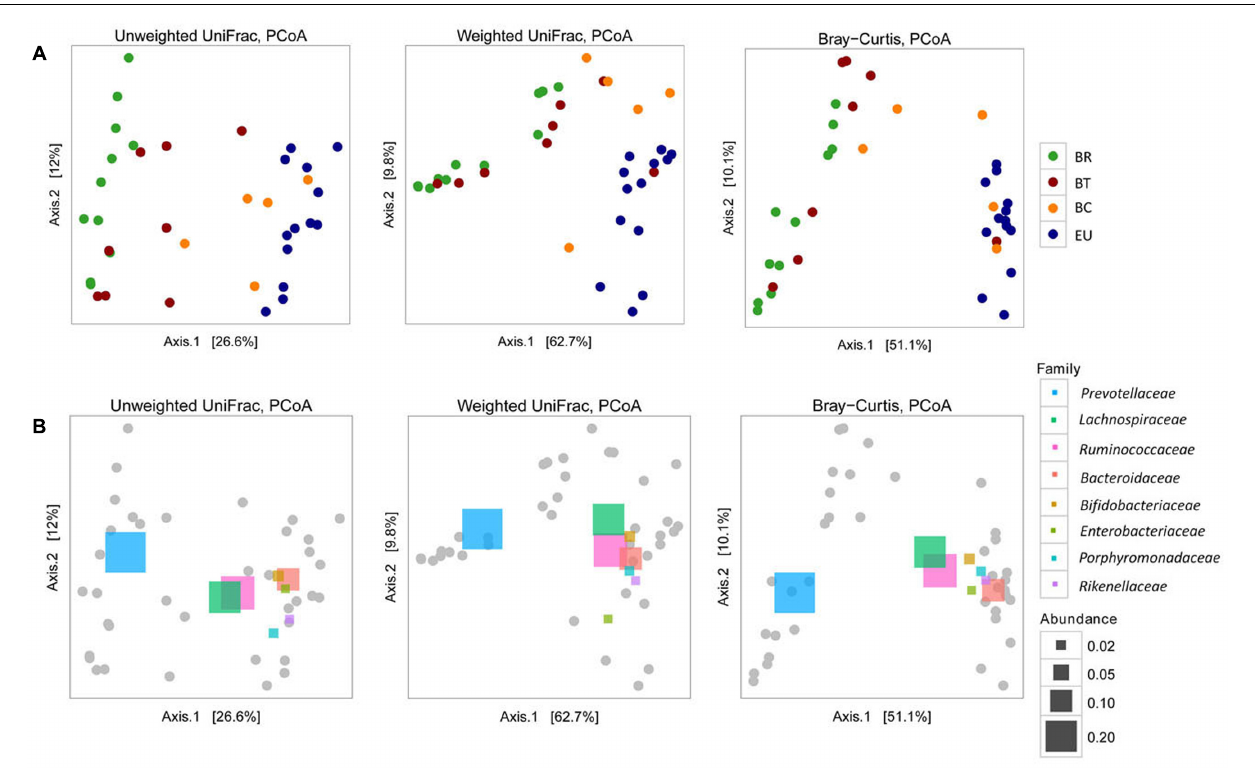
FIGURE 5 | Beta diversity (A) Principal coordinates analysis (PCoA) derived from unweighted and weighted UniFrac and Bray–Curtis distances among samples of the four populations ( p = 0.0001 by PERMANOVA). Colored dots representative of the four populations are as in Figure 4 . For each axis, in square brackets, the percent of variation explained was reported. (B) Beta diversity and correlation with the principal abundant bacterial families, represented by colored rectangles ( p = 0.0001 by PERMANOVA). Different sizes of rectangles indicate the size of relative family abundance. For each axis, in square brackets, the percent of variation explained was